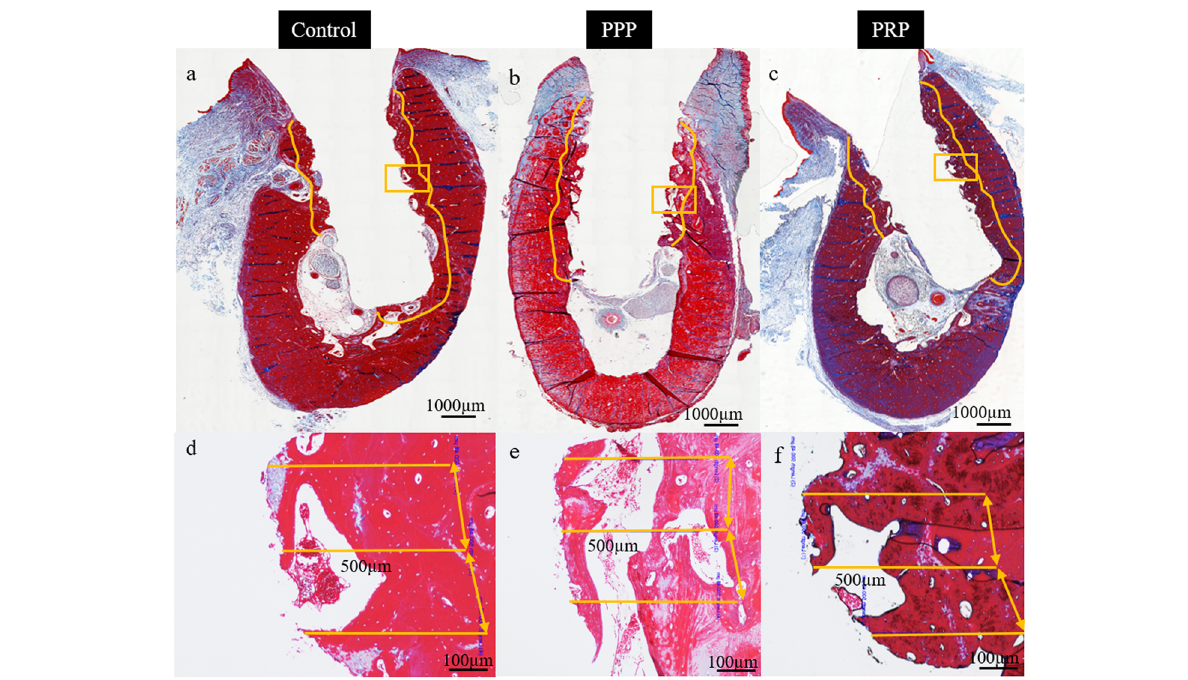
Fig. 2 Region of interest selection 500 μ m away from the implant surface on histological sections stained with Masson ’ s trichrome stain for control ( a , d ), platelet-poor plasma ( b , e ), platelet-rich plasma ( c , f ) group. All sections were after 6 months healing time and taken with a light microscope at × 10 (upper row) or × 40 magnification (bottom